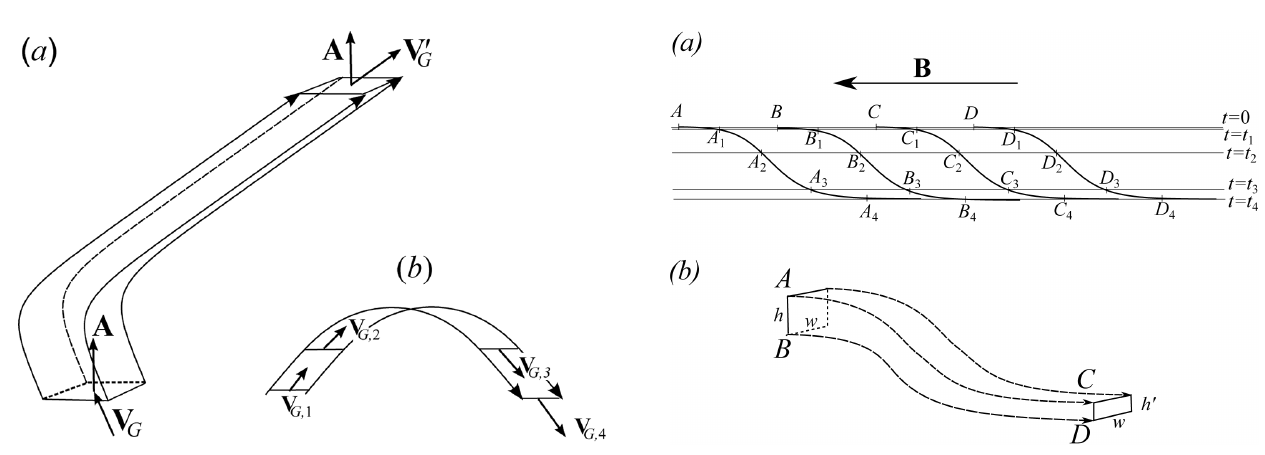
Figure 3. Ray tubes for plane waves in a shear layer. (a) Wave trans- mitted through layer. (b) Wave reflected from layer.